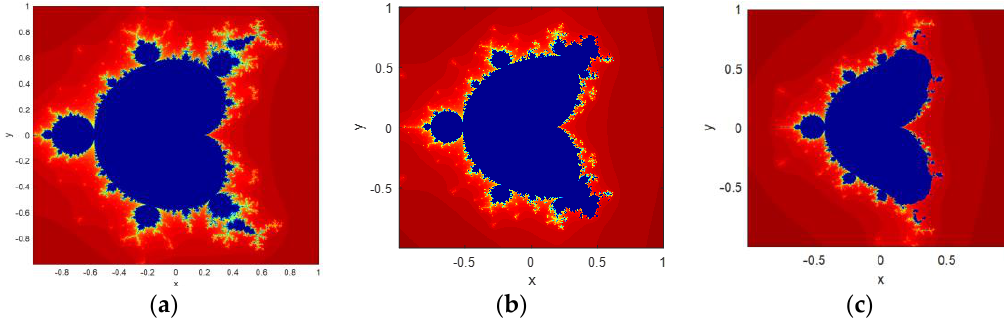
Figure 2. Fractal images generated from CFF: ( a ) 𝛽 = 0.2; ( b ) 𝛽 = 0.3; ( c ) 𝛽 = 0.5.